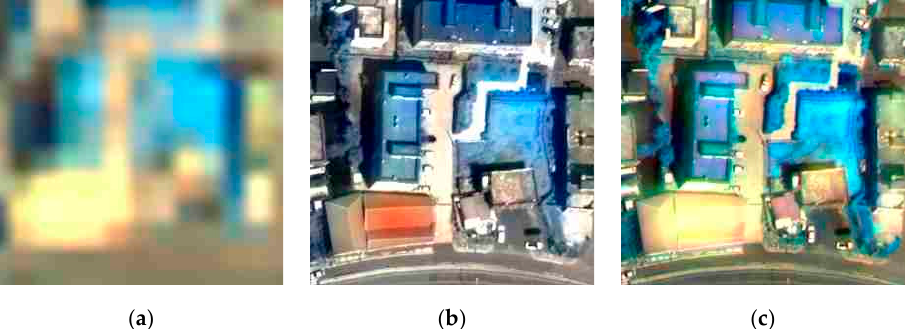
Figure 6. Results before and after applying the spectral distortion reduction technique (SWIR bands 8, 4, and 1 are shown as RGB): ( a ) original SWIR image; ( b ) results before applying the spectral distortion reduction technique; ( c ) result after applying the spectral distortion reduction technique.